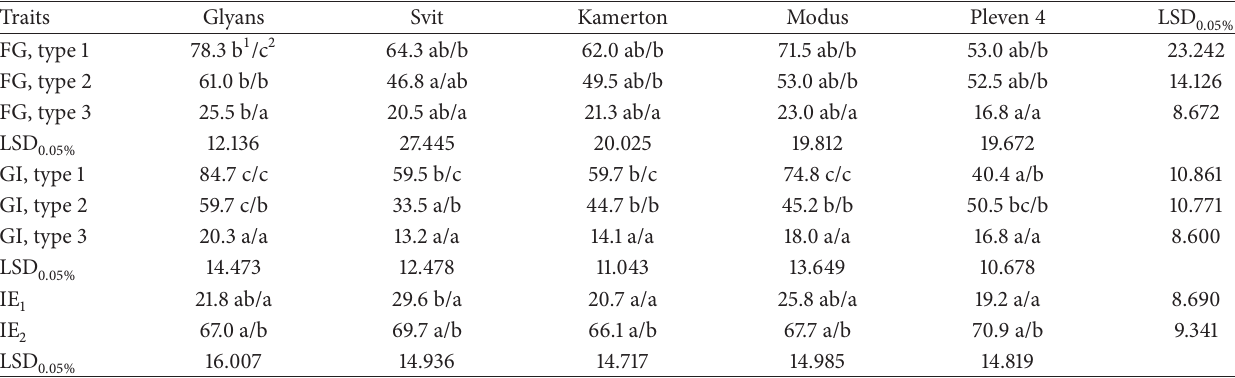
Table 3: Seed damage ratings by Bruchus pisorum in pea